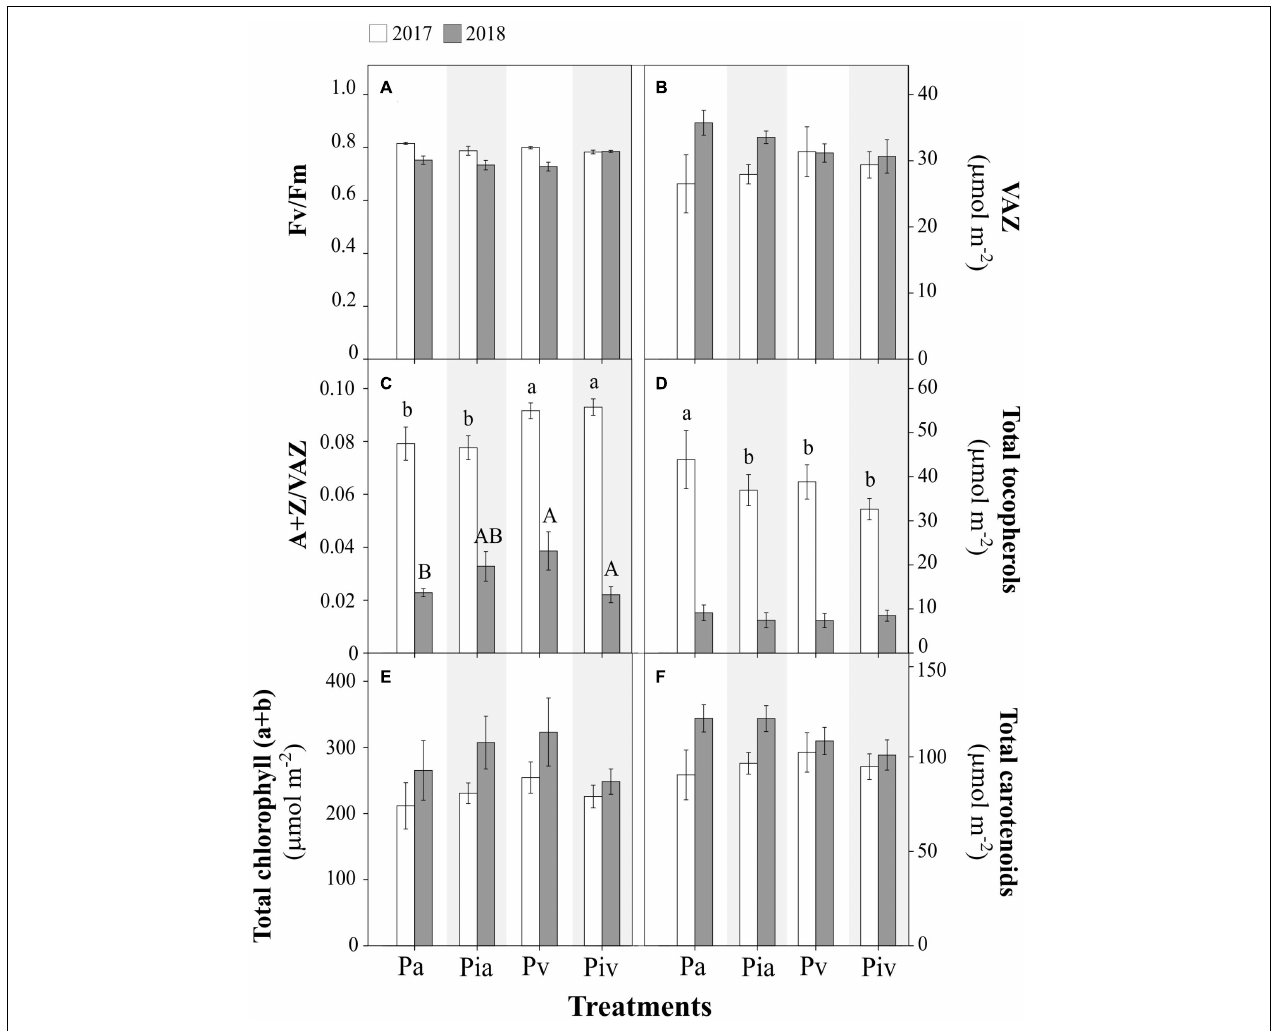
FIGURE 3 | Physiological parameters in poplar (Populus × canadensis) sapling leaves in 2017 (open bars) and 2018 (closed bars). Treatments: Pa, intercropping of non-mycorrhizal poplars with alfalfa; Pia, intercropping of mycorrhizal poplars with alfalfa; Pv, planting of non-mycorrhizal poplars with spontaneous vegetation; Piv, planting of mycorrhizal poplars with spontaneous vegetation. (A) Photochemical efficiency of PSII (F v /F m ); (B) Total xanthophyll cycle pigments (VAZ); (C) De-epoxidation state of xanthophyll cycle pigments (A+Z/VAZ); (D) Total tocopherols; (E) Total chlorophyll; (F) Total carotenoids. Small and capital letters indicate significant differences between treatments in 2017 and 2018, respectively ( p < 0.05). Each bar represents the mean ± SE ( n =